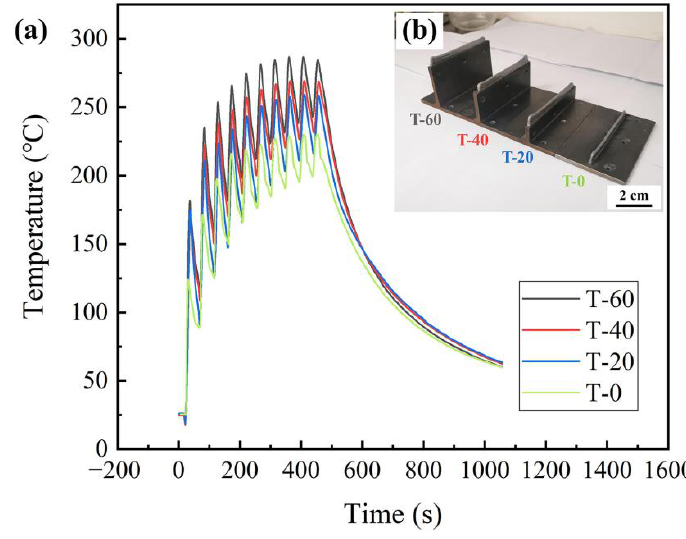
Figure 5. LMD-Al 0.5 FeCoCrNi wall under different T-beam heights: ( a ) The temperature curves of the deposition process; ( b ) Macro-morphology.